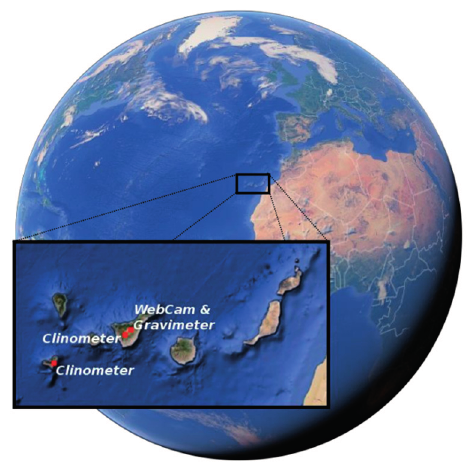
Figure 11. Location of the four different measuring